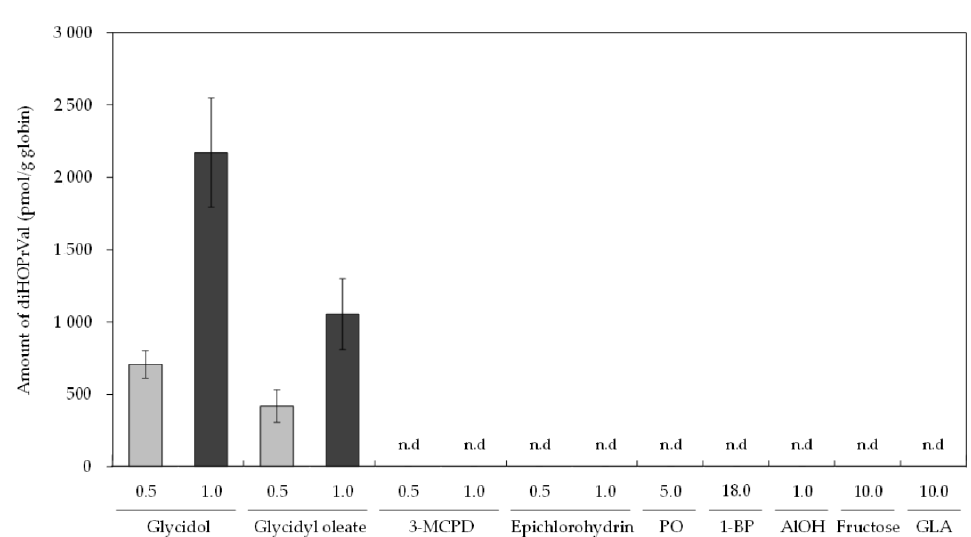
Figure 3. Amounts of diHOPrVal in the blood of mice orally administered glycidol-related chemicals (glycidol, glycidyl oleate, 3-MCPD, and epichlorohydrin, 0.5, 1.0 mmol/kg bw; propylene oxide (PO), 5.0 mmol/kg bw; 1-bromopropane (1-BP), 8.0 mmol/kg bw; allyl alcohol (AlOH), 1.0 mmol/kg bw; fructose, 10 mol/kg bw; glyceraldehyde (GLA), 10 mol/kg bw.